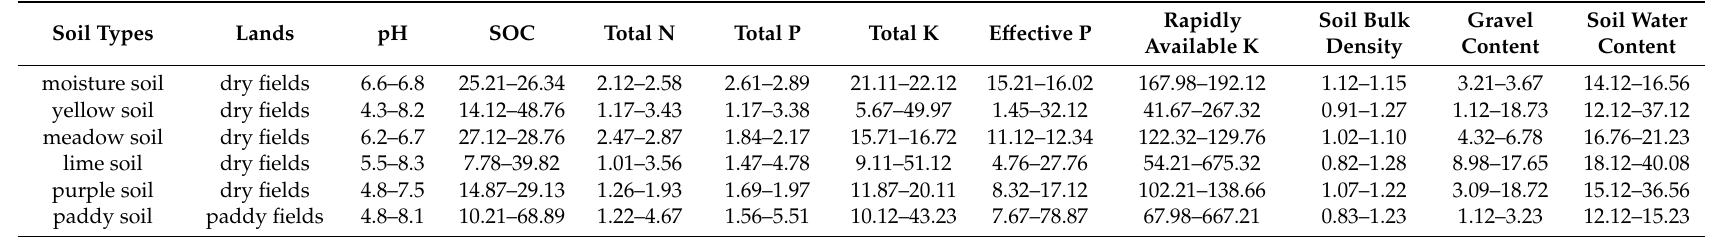
Table 2. Statistics of measured values of basic soil properties in surface layer (0~20 cm) of cultivated land in Puding County in